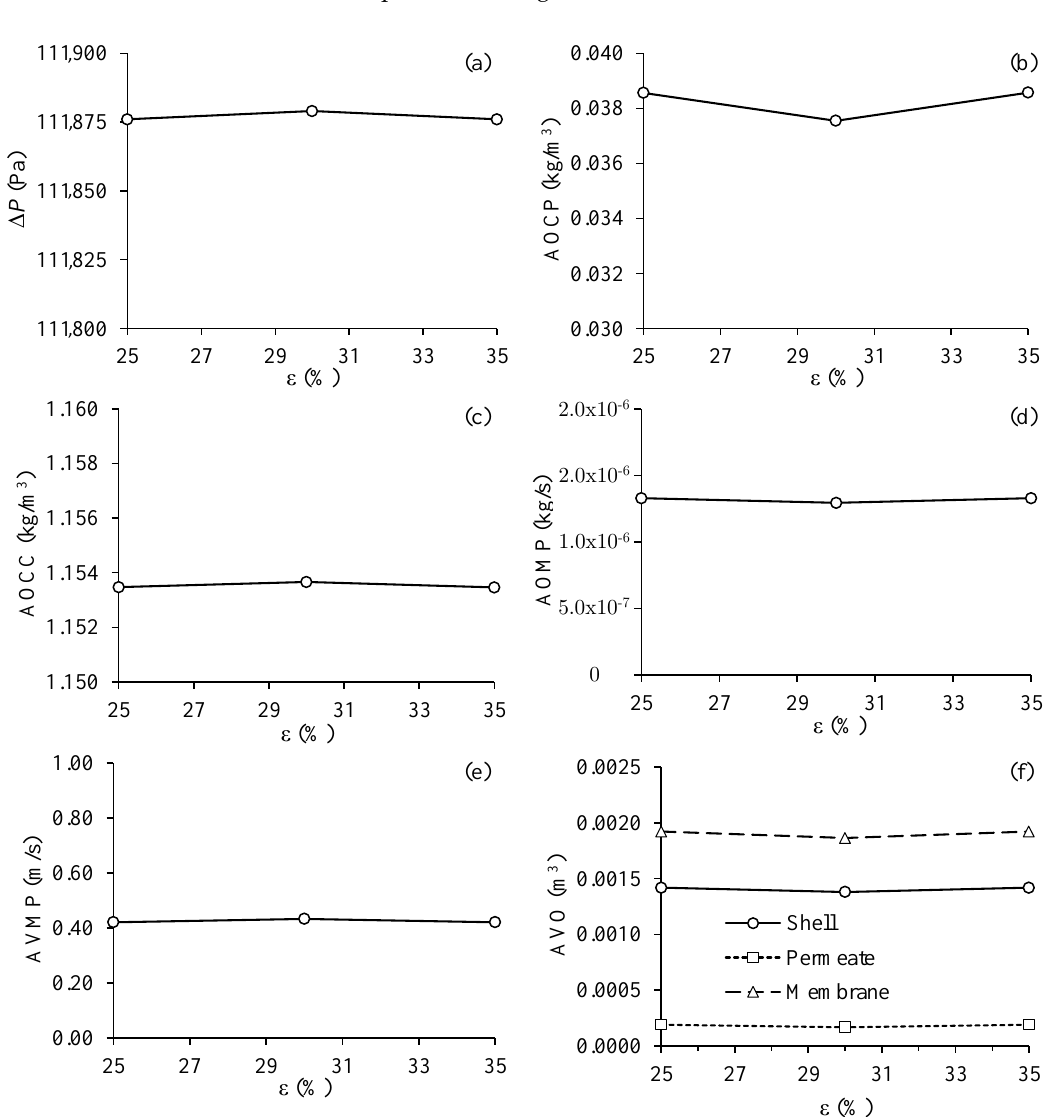
Figure 14. Process parameter in the filtration module as a function of the porosity of the membrane. ( a ) Transmembrane pressure, ( b ) average oil volumetric concentration at the permeate outlets, ( c ) average oil volumetric concentration at the concentrate outlet, ( d ) average oil mass flow rate at the permeate outlets, ( e ) average velocity of the fluid mixture at the permeate outlets and ( f ) average volume of oil present in the hull, membranes and permeate (Cases 5, 12 and